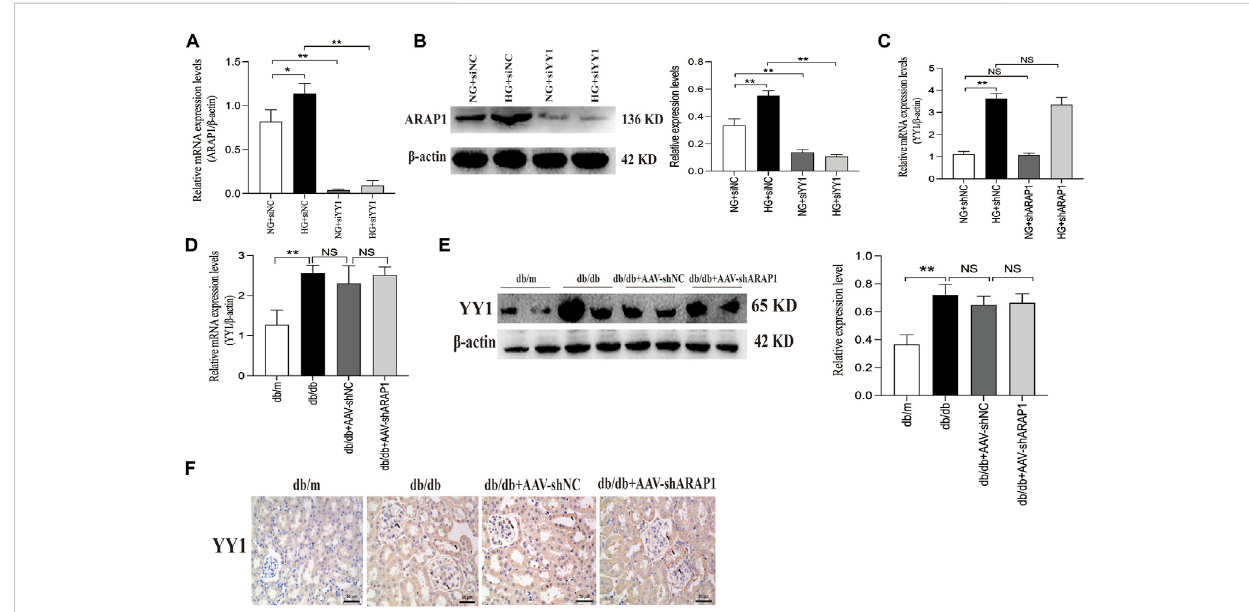
FIGURE 8 Effect of YY1 on ARAP1 (A) Forty-eight hours after transfection of the YY1 siRNA in the NG group and HG group, the mRNA expression level of ARAP1were measured by qRT-PCR. (B) Forty-eight hours after transfection of the YY1 siRNA in the NG group and HG group, the protein expression level of ARAP1 was examined by Western blot analysis. (C) Forty-eight hours after transfection of the ARAP1 shRNA in the NG group and HG group, the mRNA expression level of YY1 were measured by qRT-PCR. (D) The mRNA expressionof YY1 inthe isolated glomeruli lysates of kidney tissues from the db/ m, db/db, db/db + AAV-shNC and db/db + AAV-shARAP1 mice was measured by qRT-PCR. (E) The protein expression of YY1 in the isolated glomeruli lysates of kidney tissues from the db/m, db/db, db/db + AAV-shNC and db/db + AAV-shARAP1 mice was measured by Western blot analysis. (F)